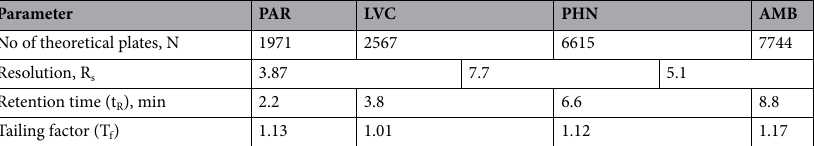
Table 5. Parameters of system suitability of the proposed HPLC method for the determination of the studied drugs using 50 µg/mL synthetic mixture chromatogram.